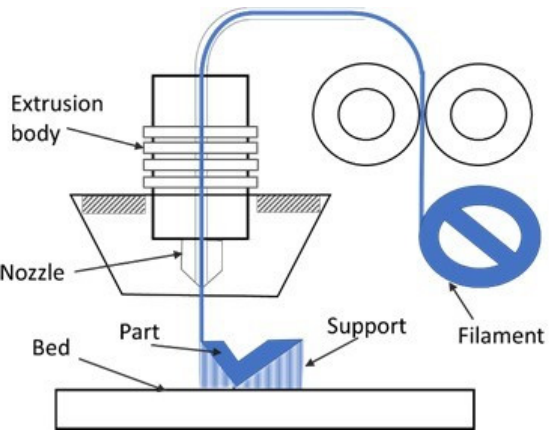
Figure 1. Schematic of fused filament fabrication (FFF) process.